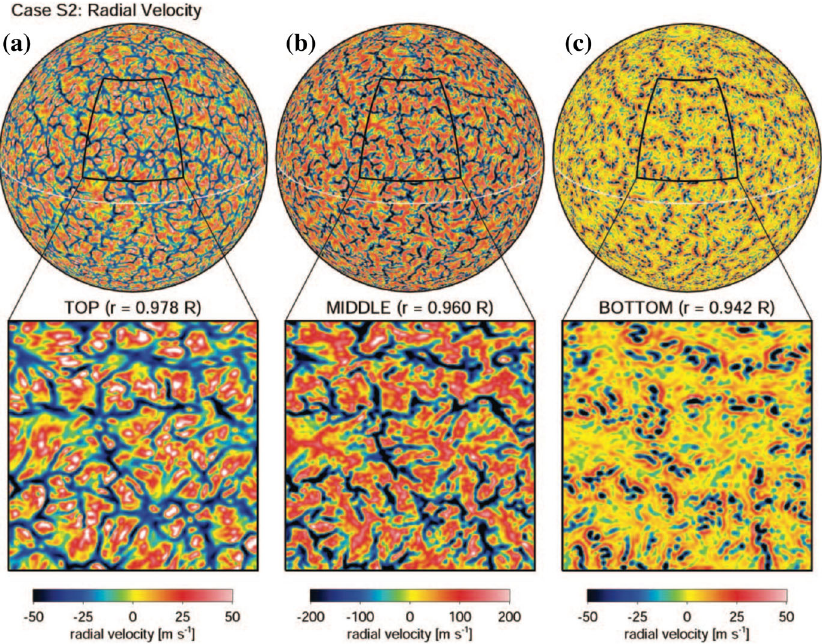
Fig.10 Radial velocity snapshots at various depths in global simulations of convection in shallow spherical shells, down to supergranulation scales. Image reproduced with permission from DeRosa et al. (2002), copyright by